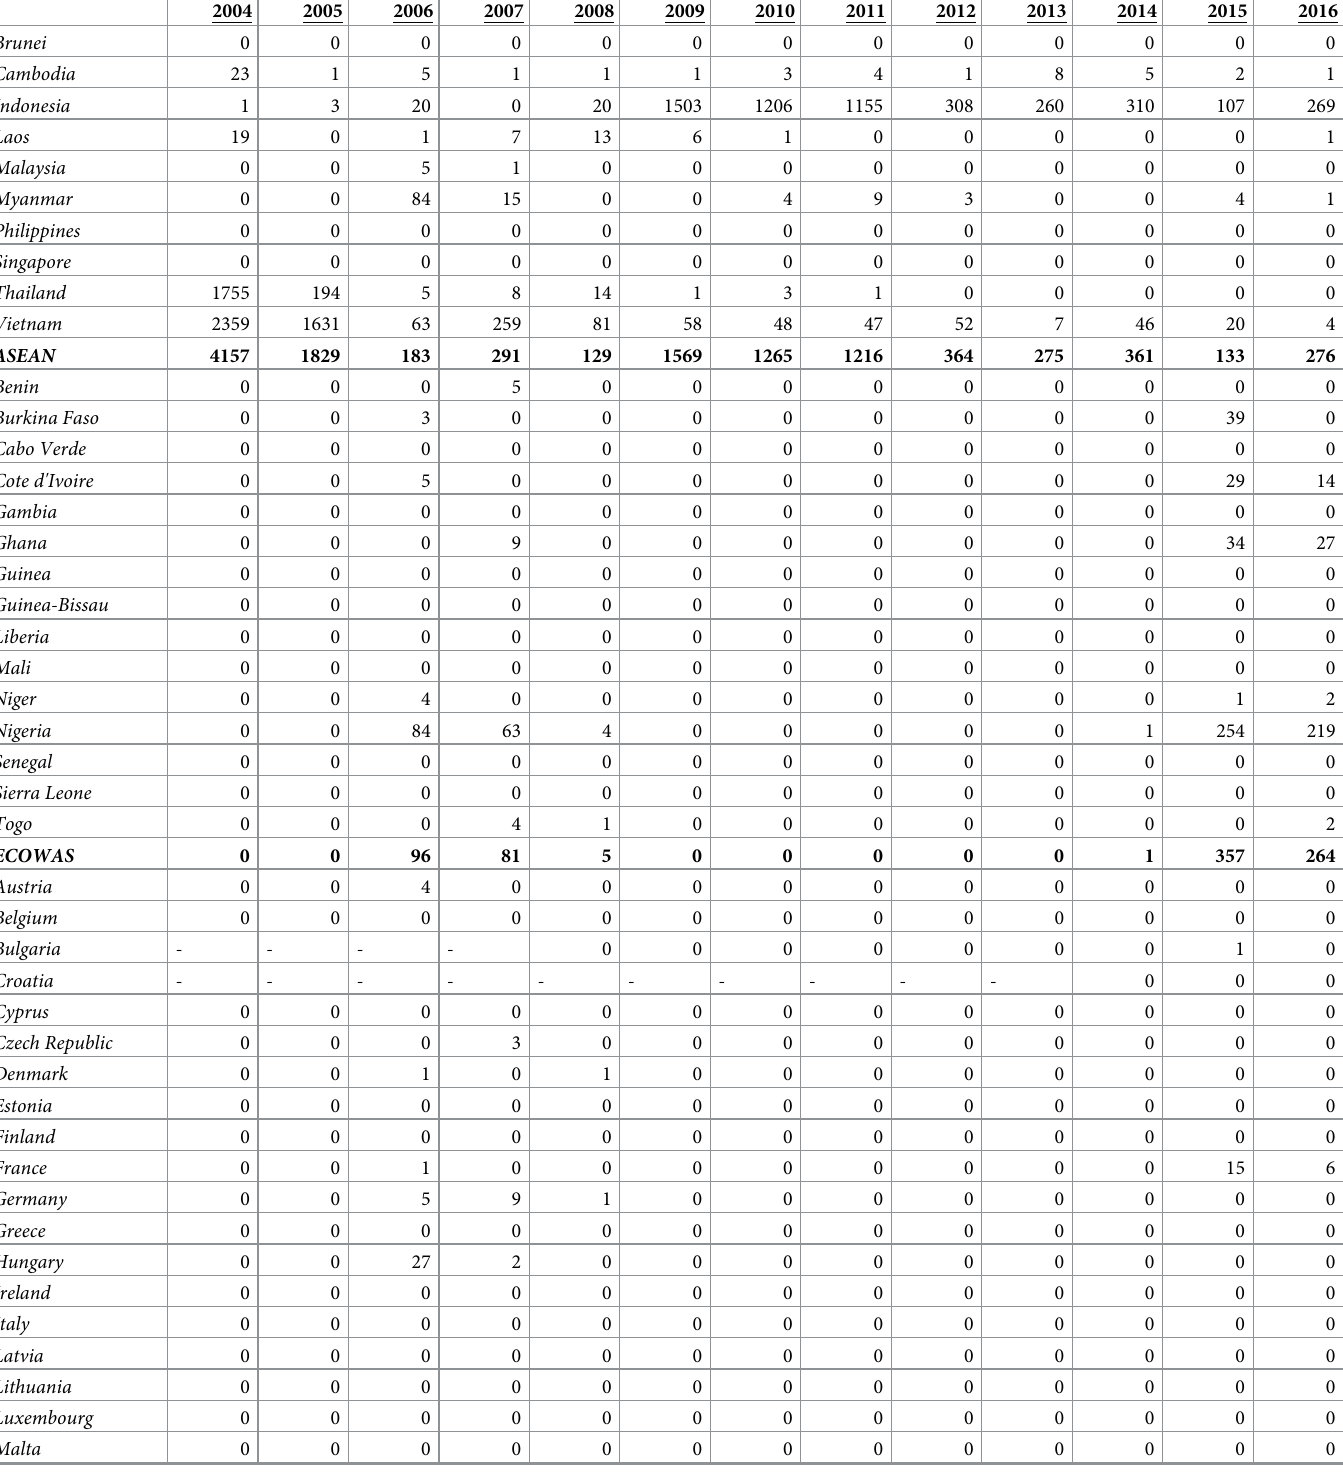
Table 1. The distribution of H5N1 poultry outbreaks between 2004–2016 across the member states of ASEAN, ECOWAS, and EU. “-” signifies that the country was not a member of its associated trade bloc in that given year.